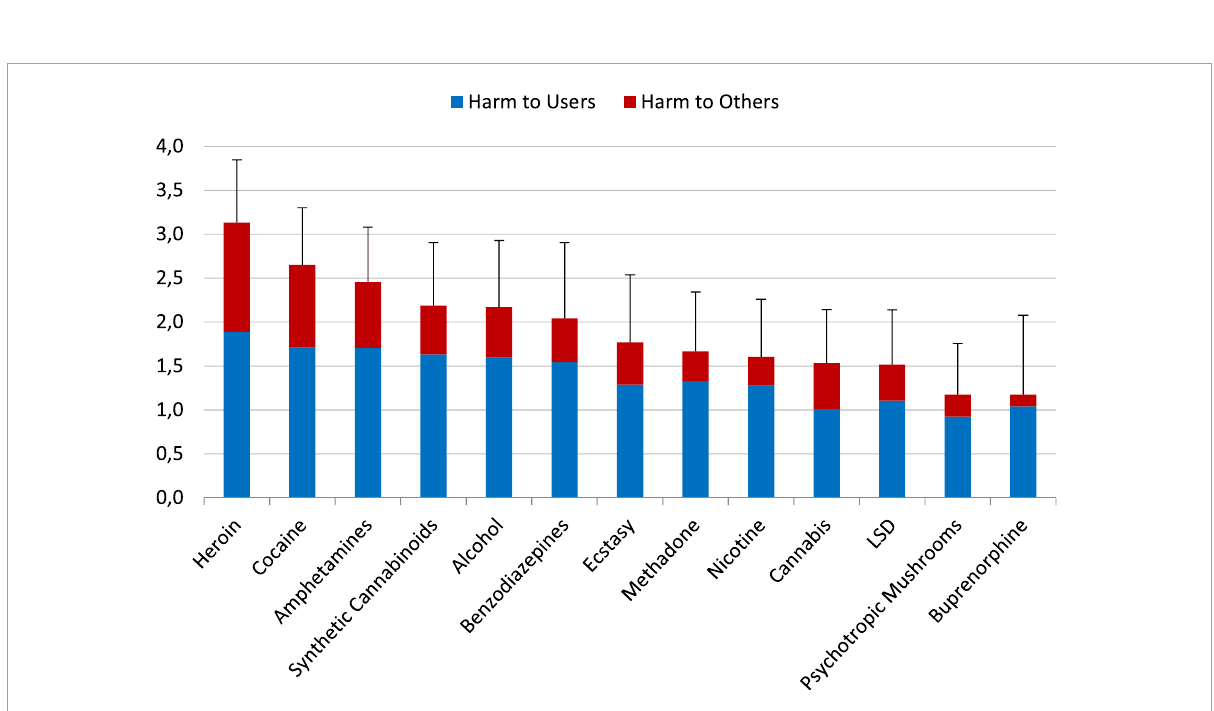
FIGURE4 Mean (SD) of the overall harm of the 13 substances using the dimension-weights of the EU-rating (8) on a scale from 0 “not harmful” to 4 “extremely harmful”. Supplementary Figure 18 shows also the results for the excluded